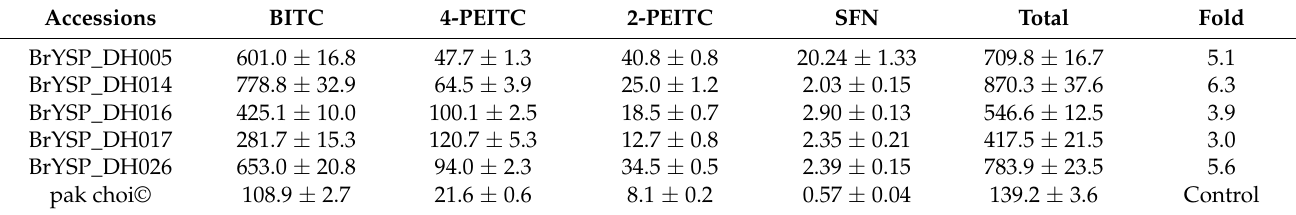
Table 4. Hydrolysis products of high glucosinolate doubled haploid (DH) lines.